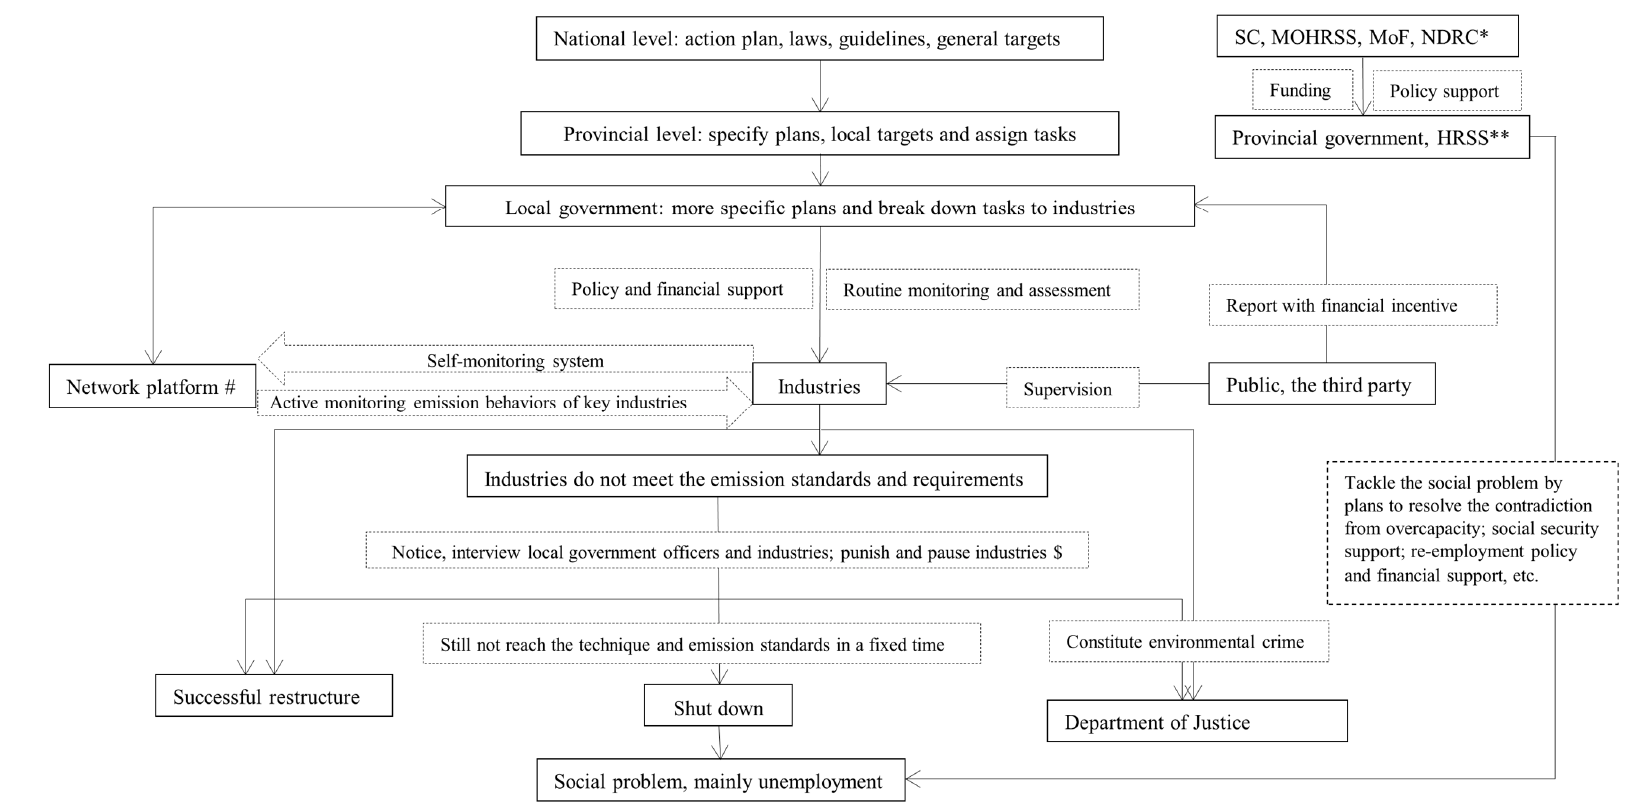
Figure 2. The implementation process of industrial restructuring in Hebei Province. This figure is drawn based on the interview. Solid line indicates institutions or the endpoints of the actions; Dotted line indicates the action process. * SC, State council; MOHRSS, Ministry of Human Resources and Social Security; MoF, Ministry of Finance; NDRC, National Development and Reform Commission. ** HRSS, Department of Human Resources and Social Security. # The network platform is from the national/provincial/local environmental sector, and can actively real ‐ time monitor the emission behavior of the key polluting industries (not open to public); The industries (only large ones) have their own emission monitoring networks (selectively open to public); The National Monitoring Centre conducts spot ‐ checks of the local industries (not exclusively the key pollution industries) and compares the emission data with the industry self ‐ monitoring data, and then reports to the MEP(Ministry of Environmental Protection). $ Department of Pollution Prevention and Control of MEP is in charge of this action; The six Environmental Protection Supervision Centres (more details see Table A5), here the North China Environmental Protection Supervision Centre, also conduct supervision in BTH region.